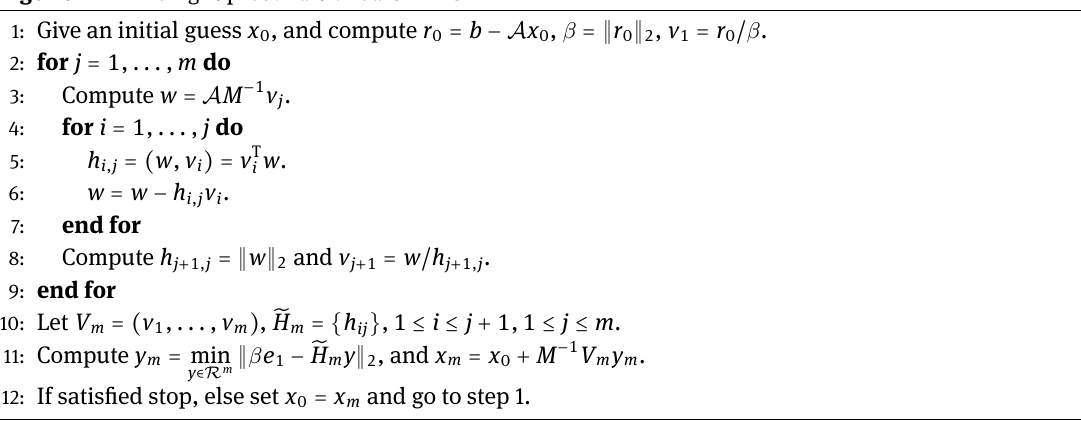
Algorithm 1 The right preconditioned GMRES